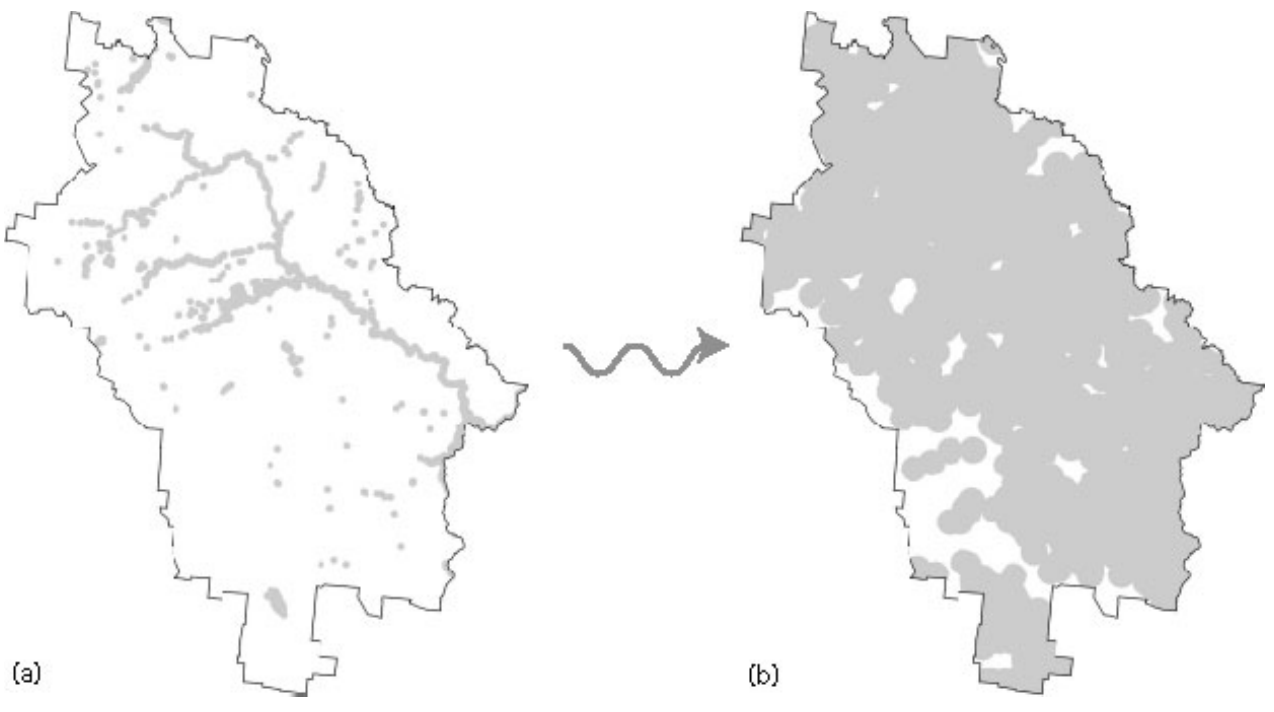
Fig. 4. Grazing land use fragmented by distance between waterpoints (from Abbott and McAllister 2004). (a) Pastoral pioneers in the Dalrymple Shire encountered disconnected fragments of useable land with access to natural water sources. (b) gradually land use expanded and became more connected by the introduction of man-made waterpoints and cattle breeds able to venture further from